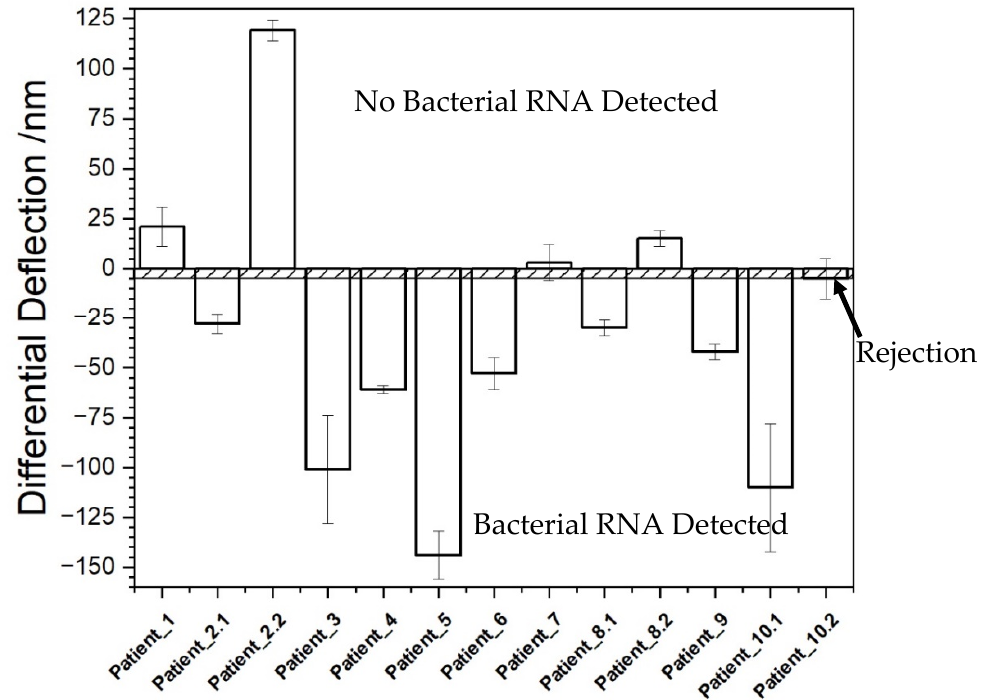
Figure 5. Cantilever responses to different patient samples. These signals allowed to decide on the status of the patients. In all cases the patients’ status was determined correctly with our method.